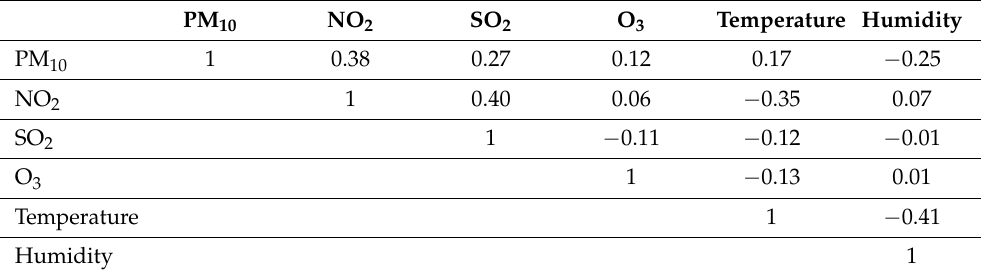
Table 2. Spearman’s rank correlation between city-level daily mean PM 10 , NO 2 , SO 2 , O 3 and meteorological parameters during the period of 1 January 2006 to 31 December 2015 in Cape Town, South